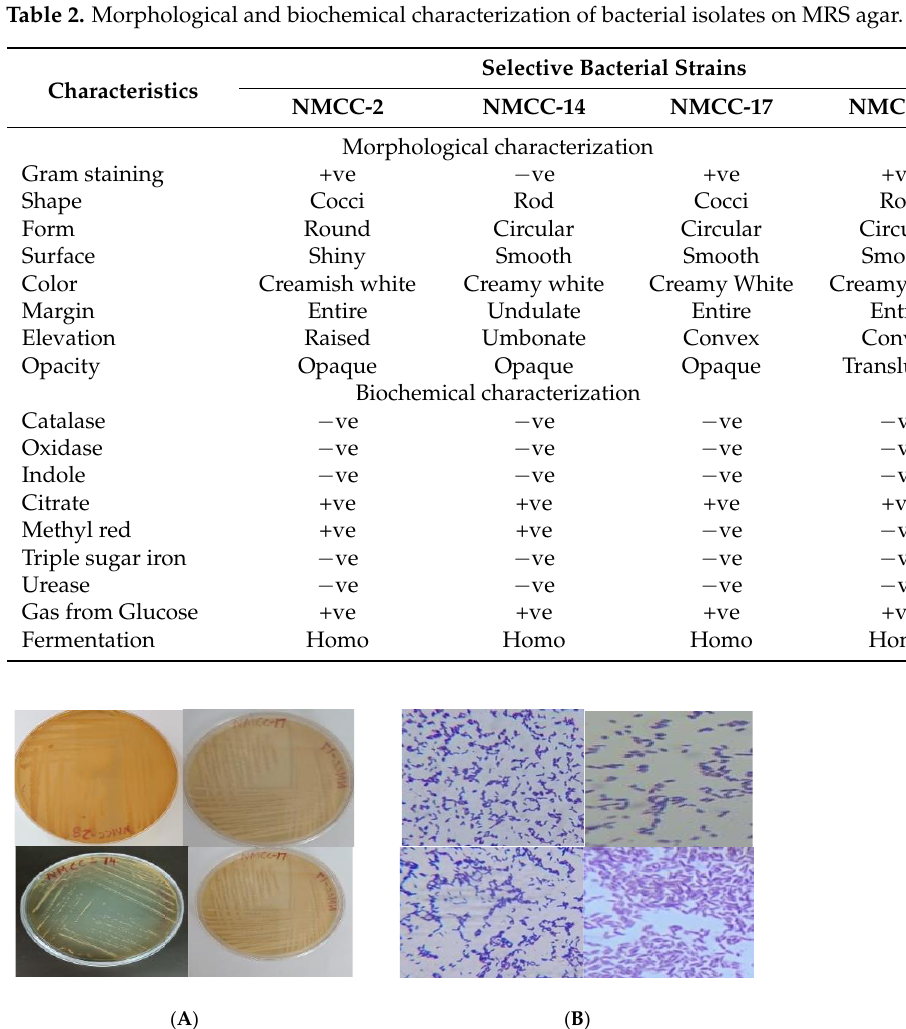
Figure 3. Proteolytic potential of the isolated LAB strains. Figure 4. Amylolytic potential of the isolated LAB strains.